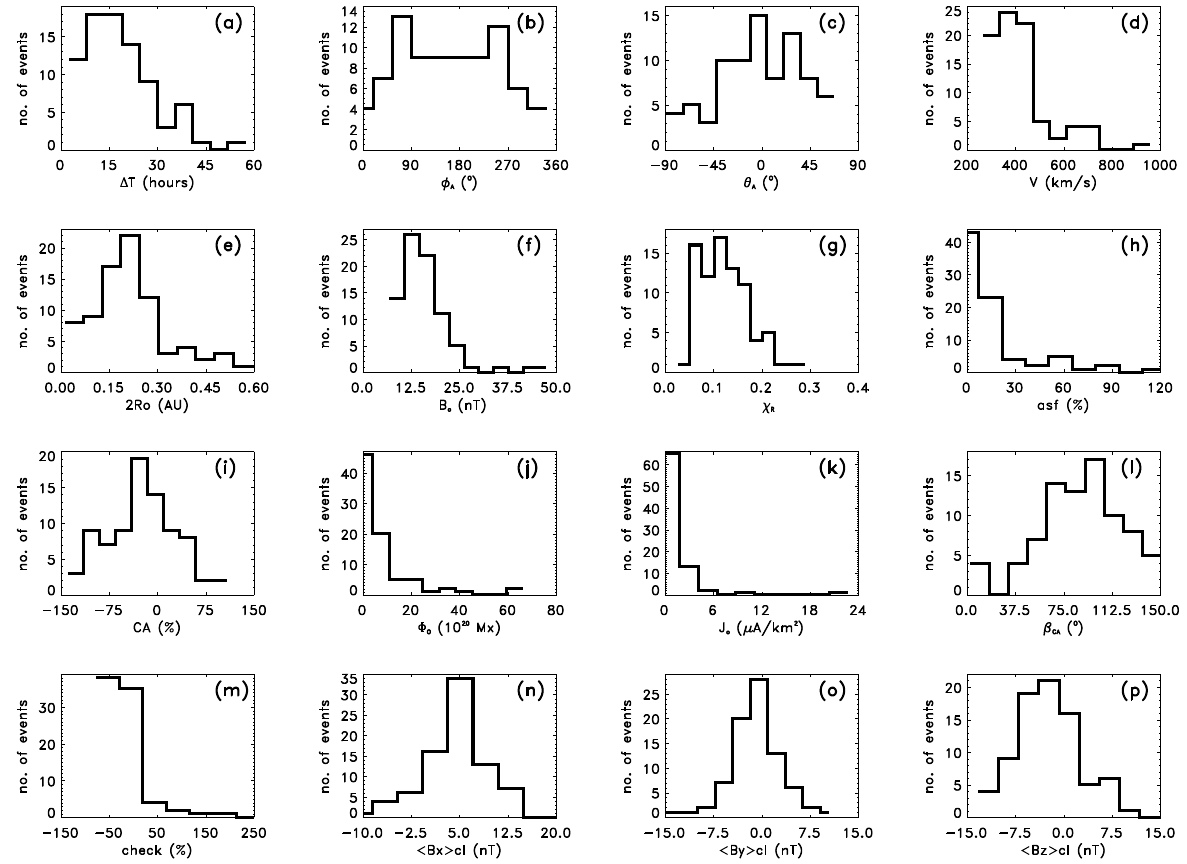
Fig. 10. Histograms of various estimated fit-parameters, by the Lepping et al. (1990) MC model, and related quantities for the 82 MCs for the period from 1995 to August 2003 given in panels (a) through (p) , respectively as: Duration ( 1 T), axis direction in terms of (GSE) longitude and latitude ( φ A , θ A ) , average speed (V), diameter (2R 0 ) , axial field magnitude (B 0 ) , square root of reduced chi-squared of fit ( χ R ) , asymmetry factor (asf(%)), relative closest approach distance CA(%), axial magnetic flux ( 8 0 ) , current density on the axis (J 0 ) , axis cone angle ( β CA ) with respect to the X(GSE)-axis, radius-check(%), average of the MC’s field in Cloud coordinates, ( < B X > Cl , < B Y > Cl , < B Z > Cl ) ; see the text for a definition of Cloud